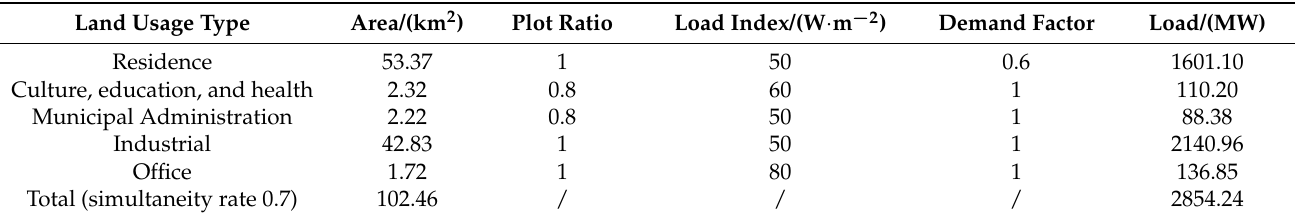
Table 2. Long-term new load